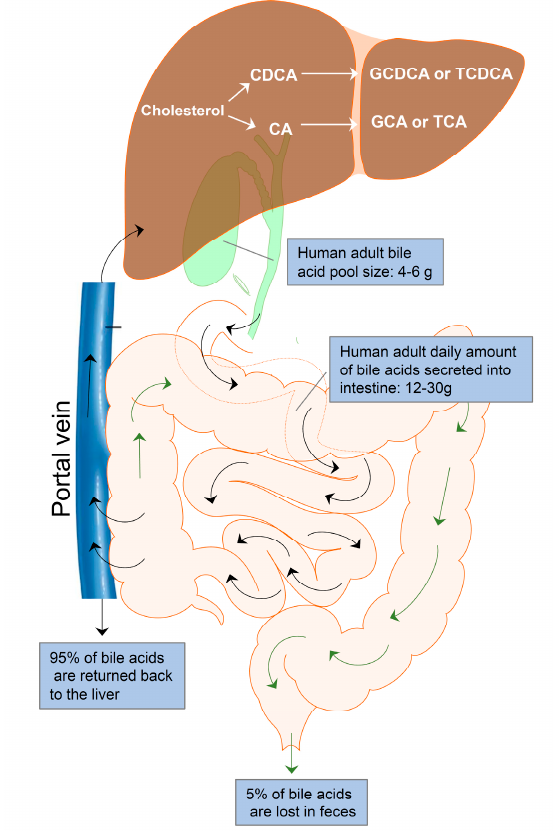
Figure 1. Enterohepatic bile acid circulation. Bile acids are synthesized from cholesterol in the hepatocytes to form the primary bile acids, cholic acid (CA) and chenodeoxycholic acid (CDCA). CA and CDCA are conjugated with glycine or taurine to form conjugated bile acids, GDCA, TDCA, GCA, and TCA. Bile acids are stored in the gallbladder and released into the intestine after meals for facilitating nutrition solubilization and absorption. Most bile acids (95%) are reabsorbed by ileum epithelial cells and transported to the liver via the portal vein. Only 5% of bile acids are lost in feces and replaced by de novo synthesis in the hepatocytes. The average adult bile pool size is about 4–6 g, and the average daily amount of bile acids secreted into the intestine is approximately 12–30 g with 3–5 circulations.